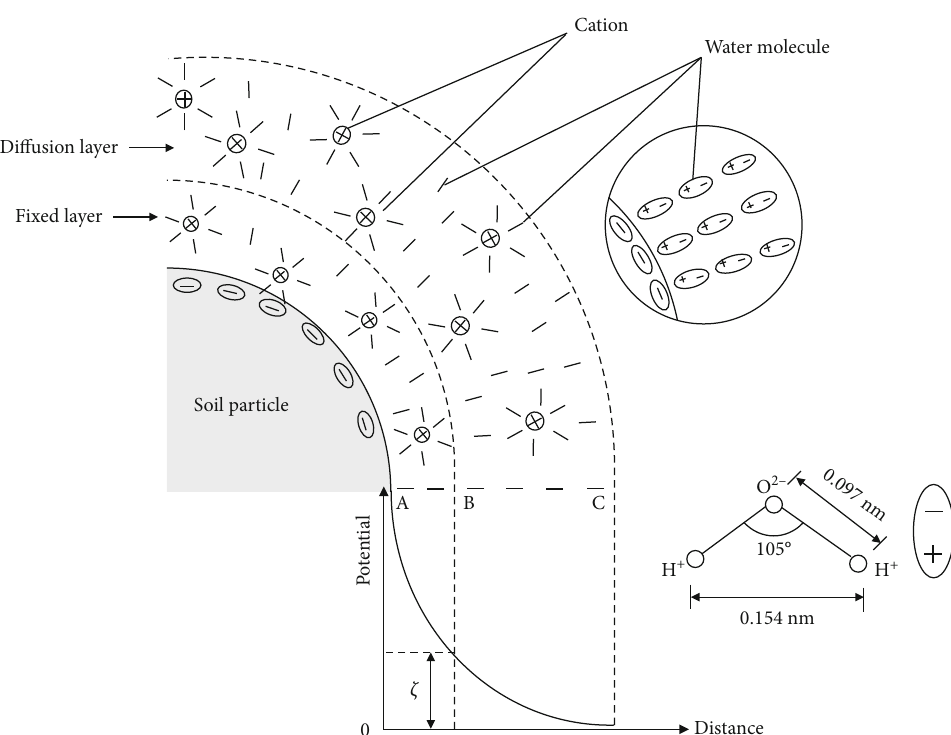
Figure 4: Electric double layer (EDL) of soil